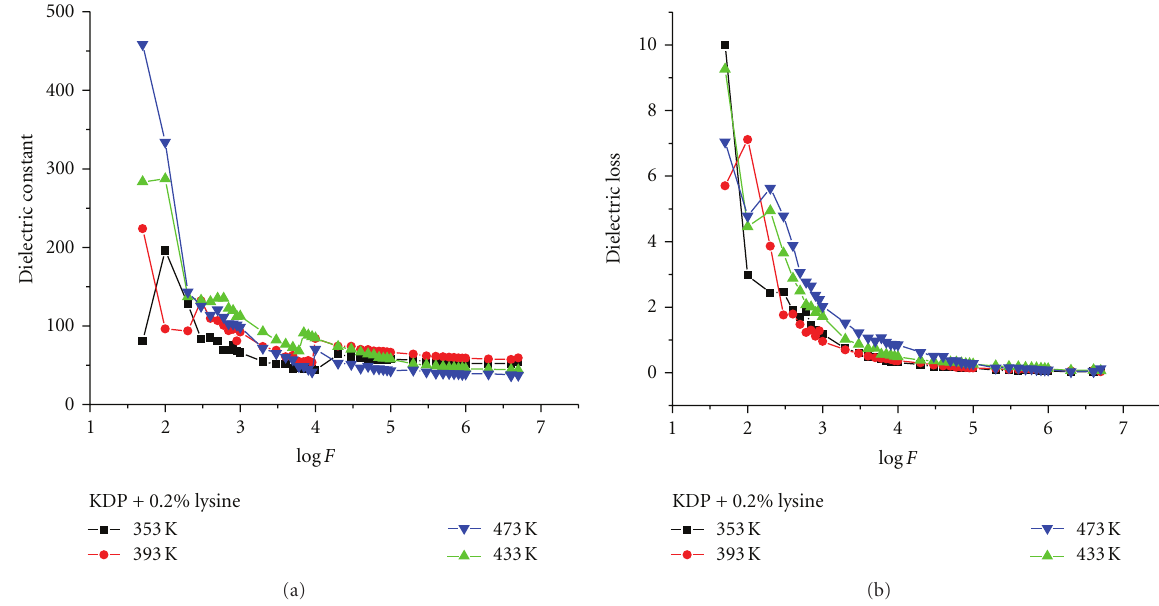
Figure 3: (a) variation of dielectric constant with frequency for all temperatures (lysine-doped KDP). (b) variation of dielectric loss with frequency for all temperatures (lysine-doped